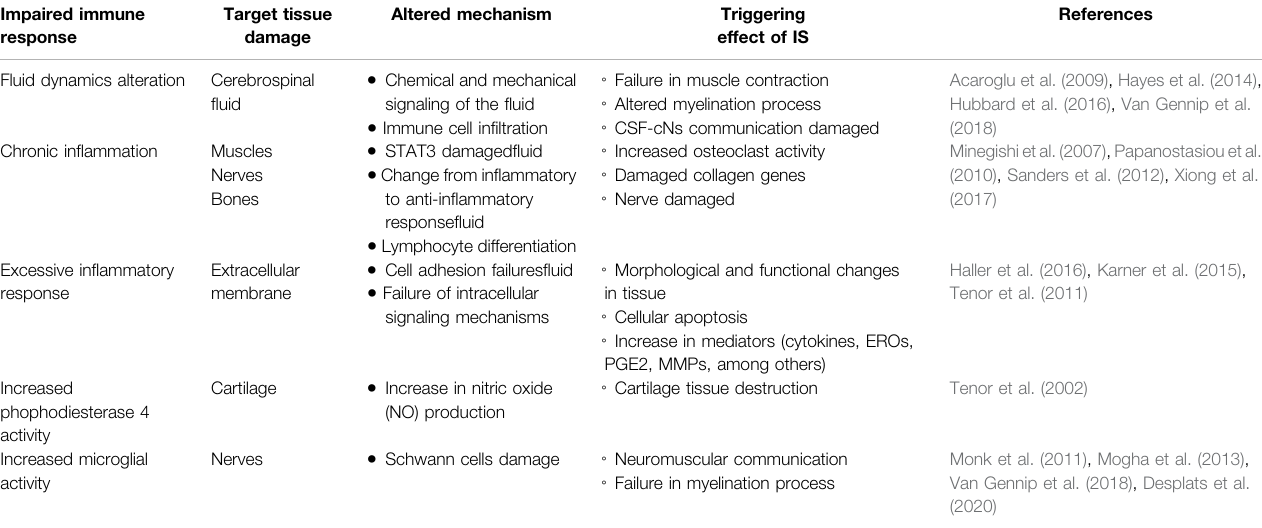
TABLE 2 | In fl ammatory responses and their implications in AIS